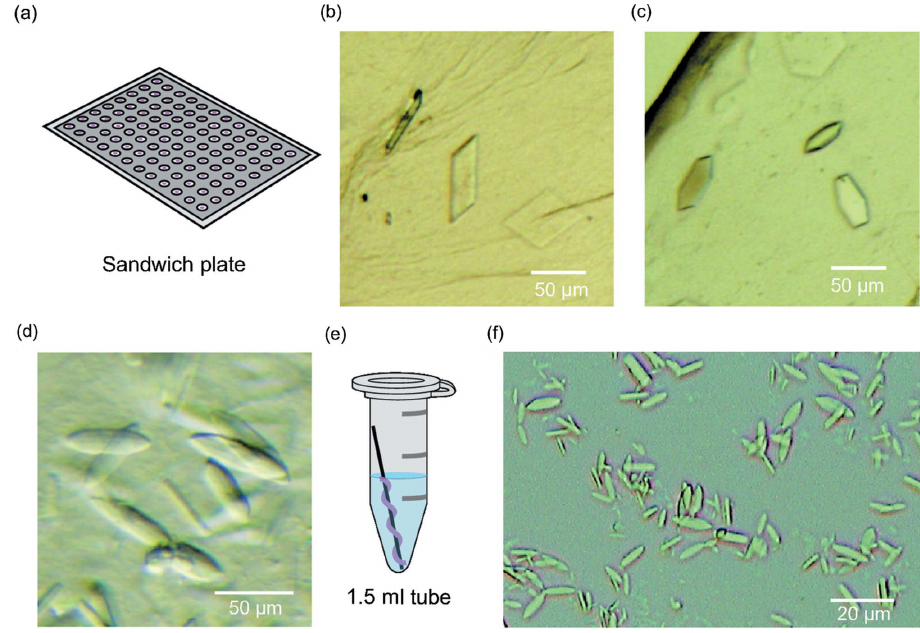
Figure 1 LCP crystals of CmABCB1. ( a ) A diagram of the 96-well glass sandwich plate used for LCP crystallization. ( b ) Rectangular plate crystals, ( c ) hexagonal plate crystals and ( d ) leaf-shaped crystals of CmABCB1 QTA formed on the glass sandwich plate. ( e ) A diagram depicting batch LCP crystallization of CmABCB1 in a 1.5 ml tube. ( f ) Microcrystals of CmABCB1 QTA formed using the batch